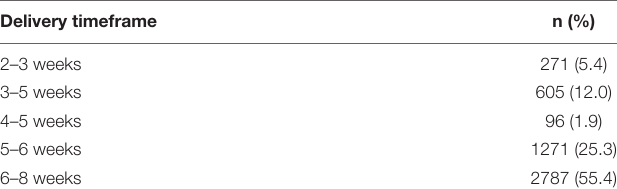
TABLE 3 | Summary of device delivery time